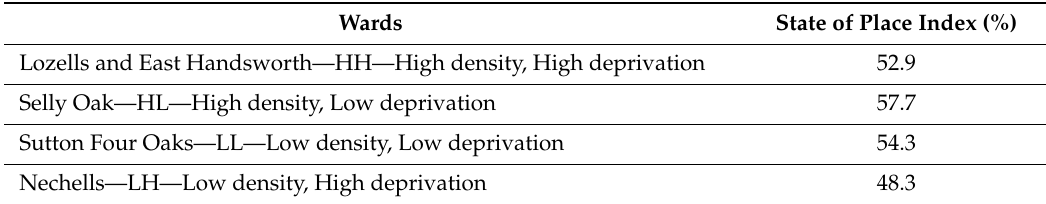
Table 2. State of Place